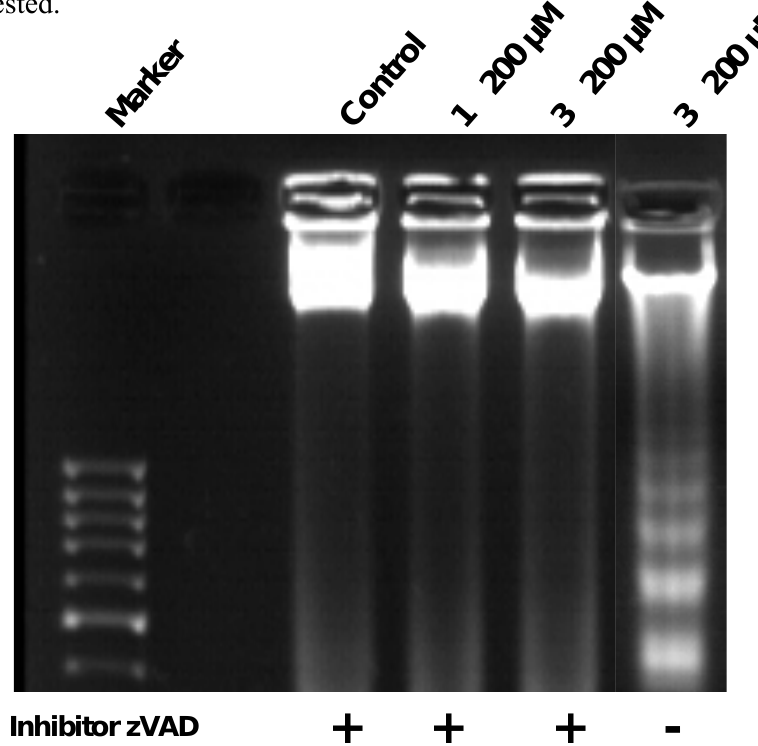
Figure 6. Chalcone induced apoptosis of HepG2 cells depends on the activation of caspases. Cells were treated with zVAD (50 µM) for 2 h and then incubated with chalcones 1 and 3 (200 µM) for 24 h. (cases marked by +). When the cells were incubated in absence of inhibitor (case -), typical laddering indicative of apoptosis was observed. Only representative compounds 1 and 3 are shown, but similar activity were found for all compounds tested.